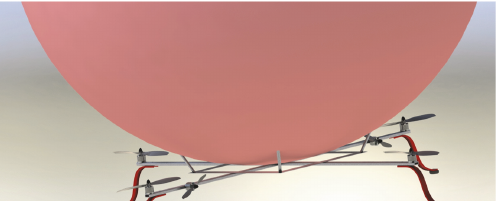
Figure 14: Newest configuration to reduce